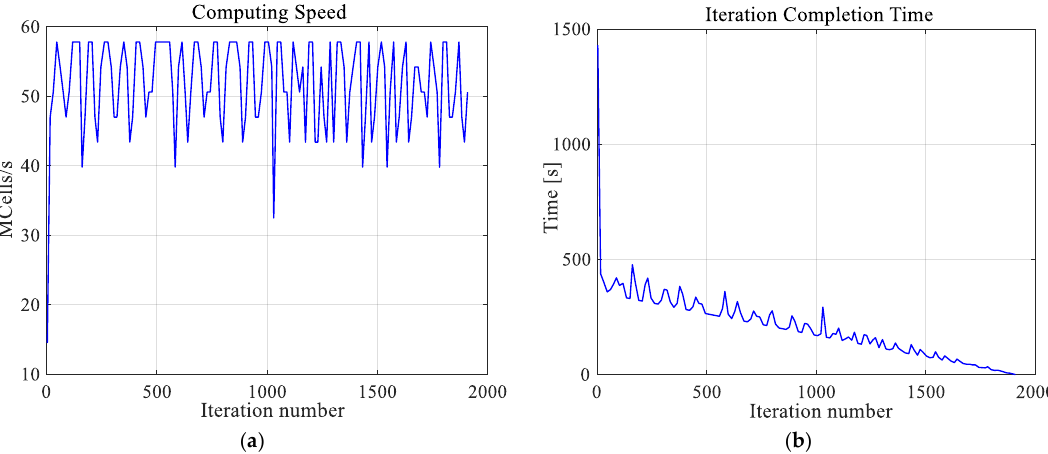
Figure 5. The computing speed ( a ) and iteration completion time ( b ) as function of iterations number for the thermal solver. The convergence was obtained after 1911 iterations.